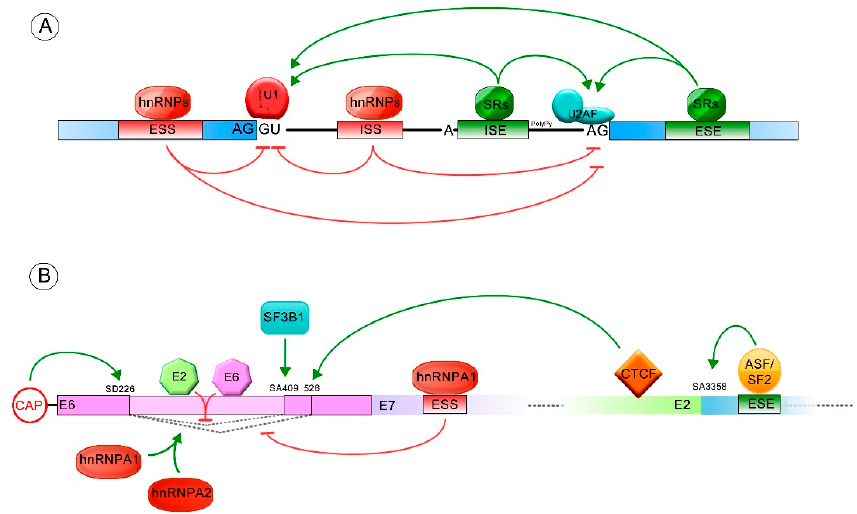
Figure 2. Splicing regulation. Green arrows indicate positive splicing regulation, while red arrows represent negative splicing regulation. ( A ) General regulation mediated by cis and/or trans elements is shown. The exonic and intronic splicing enhancers (ESE and ISE) frequently stimulate the splicing process by binding to serine/arginine-rich proteins (SR proteins). The exonic and intronic splicing silencers (ESS and ISS) commonly repress the splicing process, through binding with heterogeneous ribonucleoproteins (hnRNP) regulatory proteins; ( B ) Splicing regulated by cis and trans acting elements, allowing formation of different E6/E6* transcript patterns. The ESS and ESE sequences (exonic splicing silencer and enhancer, respectively) and the splicing donor (SD) and acceptor (SA) sites involved in E6 splicing regulation are also shown.